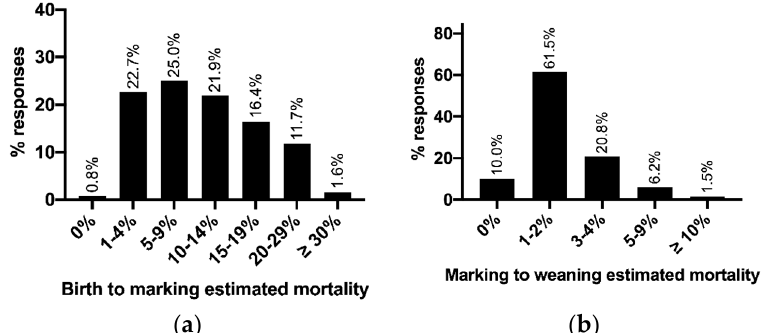
Figure 2. Producer estimated lamb mortality rates from a 2019 NSW sheep producer survey: ( a ) from birth until marking ( n = 128); ( b ) from marking to weaning ( n = 130).